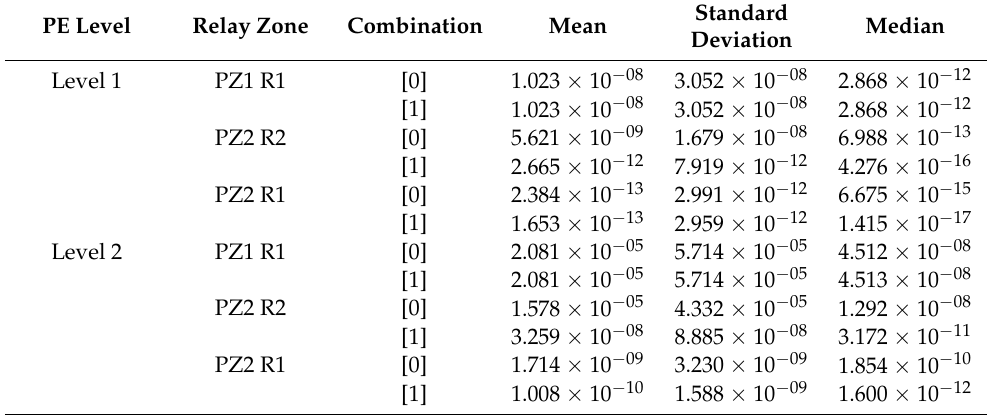
Table A3. PE values